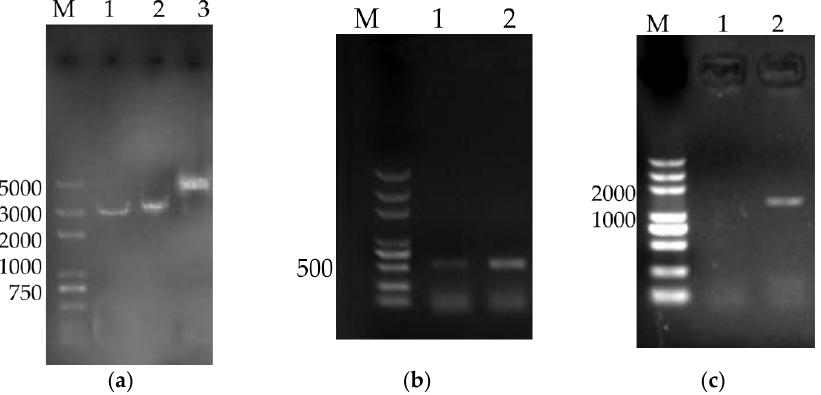
Figure 1. Agarose gel electrophoresis of VAP and VAP4/6 ( a ) (lane M: DL 5000 DNA Marker, lane 1: pVAX1 2999 bp, lane 2: VAP, lane 3: VAP4/6). Polymerase chain reaction (PCR) of cathelicidin antimicrobial peptides (CAMPs) ( b ) (lane M: DL 5000 DNA Marker, lane 1-2: VAP,) and CAMPs-IL-4/6 ( c ) (lane M: DL 5000 DNA Marker, lane 1: Negative Control, lane 2: VAP4/6).